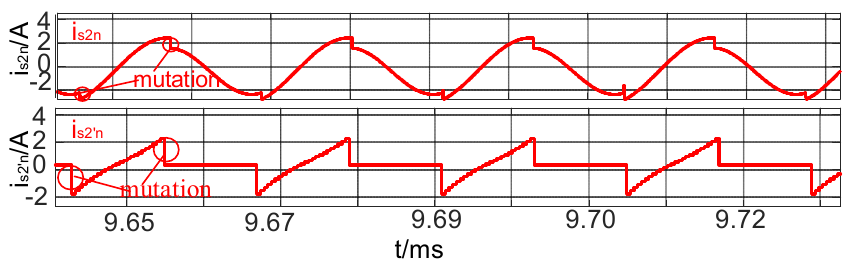
Figure 10. The input current waveform of traditional parallel resonance circuit in static mode .